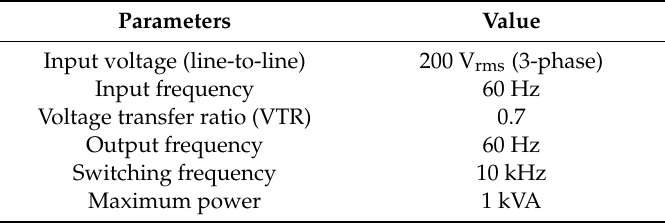
Figure 8. Schematic of matrix converter system. Table 3. Experimental electrical specifications.